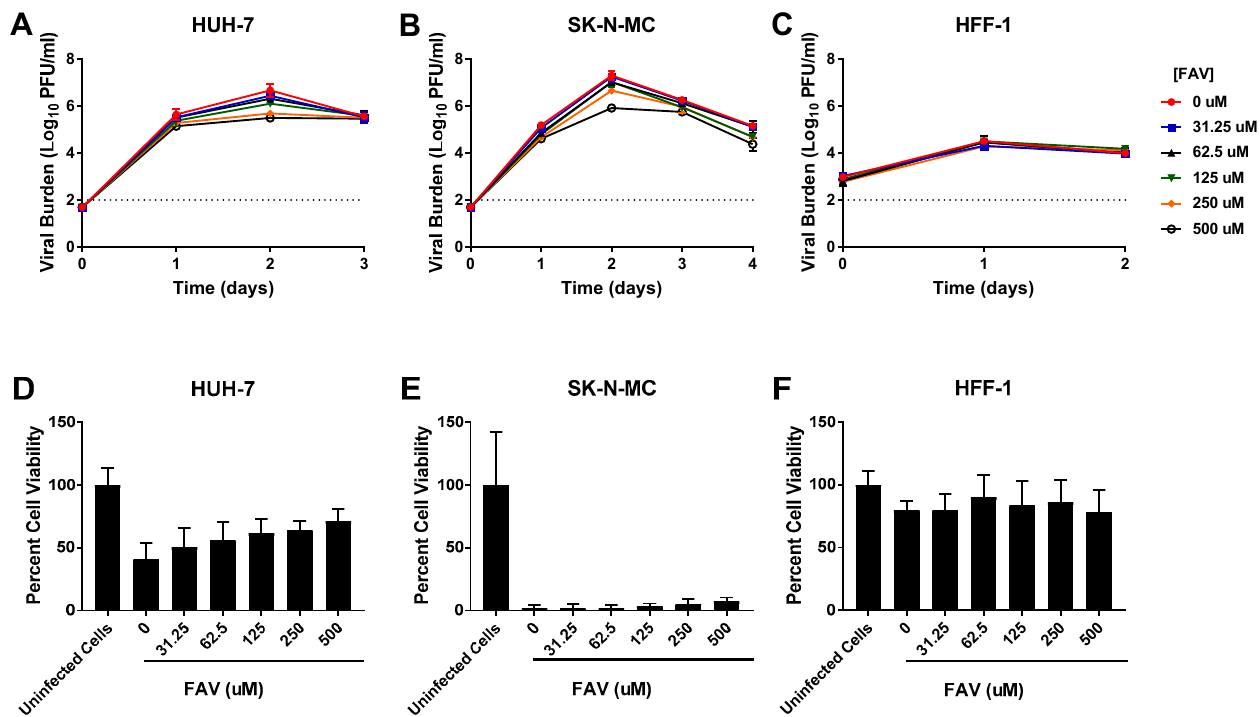
Figure 4. Antiviral activity of favipiravir (FAV) against dengue virus (DENV) in HUH-7, SK-N-MC, and HFF-1 cells ( A – C ). HUH-7 ( A ) cells were infected at a multiplicity of infection (MOI) of 0.01, and SK-N-MC ( B ) and HFF-1 ( C ) cells were infected at an MOI of 0.1. Infected cells were treated with different concentrations of FAV. Viral burden was quantified via plaque assay on Vero cells, and reported as log 10 plaque forming units per mL (PFU/mL). Data points represent the mean of three independent samples, and error bars correspond to one standard deviation. The dashed line signifies the assay limit of detection. ( D – F ) Effect of FAV treatment on cell viability of DENV-infected HUH-7 ( D ), SK-N-MC ( E ), and HFF-1 ( F ) cells. HUH-7, SK-N-MC, and HFF-1 cells were infected with DENV at MOIs of 0.01, 0.1, and 1, respectively, then treated with different concentrations of FAV. Cell viability was measured after three days with the commercially available WST-1 assay according to manufacturer specifications. Cell viability is reported as percent cell viability relative to an untreated, uninfected control. Columns represent the mean of 6 independent samples, error bars represent one standard deviation.